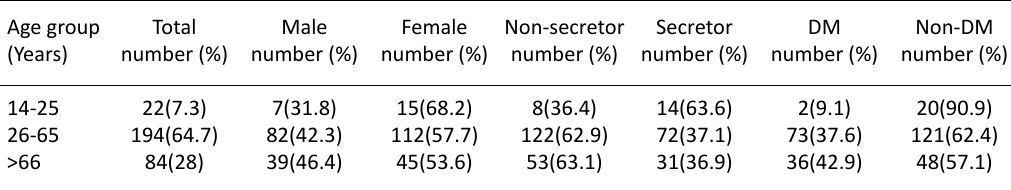
Table 3. Demographic distribution of patients in the study with Diabetic and Secretor status Age group Total Male Female Non-secretor